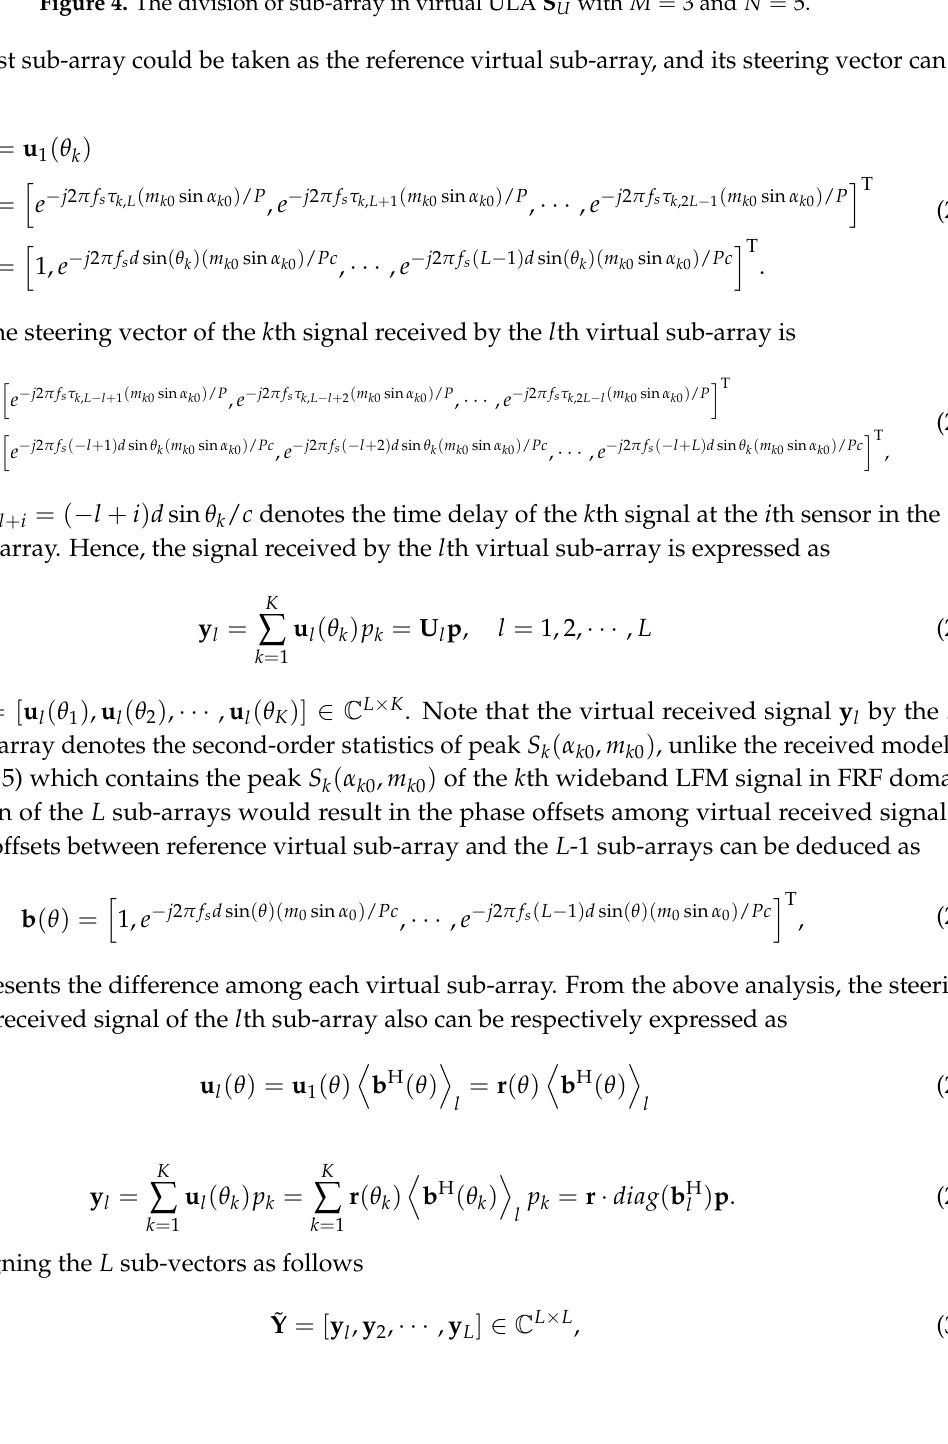
Figure 4. The division of sub-array in virtual ULA S U with M = 3 and N =